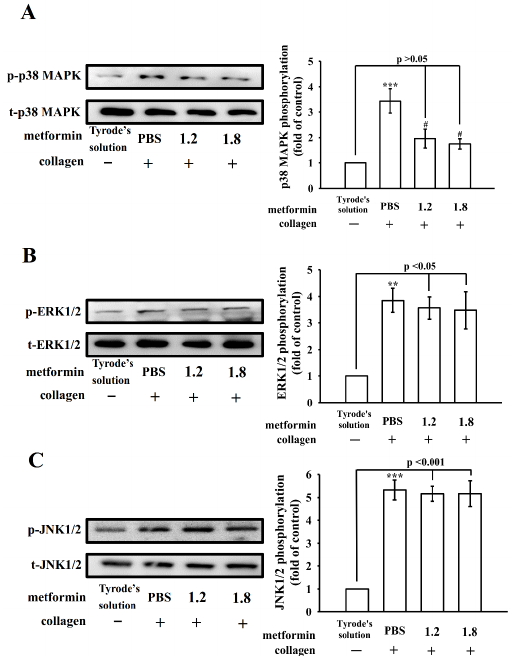
Figure 6. Regulatory activity of metformin in mitogen-activated protein kinase phosphorylation in platelets. Washed platelets were preincubated with PBS or metformin (1.2 and 1.8 mM) and treated with collagen (1 μ g/mL) for immunoblotting of ( A ) p38 mitogen-activated protein kinase (p38 MAPK), ( B ) ERK1/2, and ( C ) JNK1/2 phosphorylation. Data are expressed as mean ± standard error of the mean ( n = 4). ** p < 0.01 and *** p < 0.001 vs. Tyrode’s solution; # p < 0.05 vs. PBS + collagen group. 3.5. Effect of Metformin in Phosphorylation of VASP Cyclic adenosine monophosphate (cAMP) and cyclic guanosine monophosphate (cGMP) are small cyclic monophosphates. These nucleotides are vital messengers in sev- eral signaling pathways involved in the regulation of multiple targets, especially in the phosphorylation of VASP. As presented in Figure 7, PGE 1 (20 nM) and NTG (10 μ M) trig- gered VASP ser157 and VASP ser239 phosphorylation, respectively; treatment with H89 (a pro- tein kinase A inhibitor; 100 μ M) and KT5823 (a protein kinase G inhibitor; 10 μ M) reduced VASP ser157 and VASP Ser239 phosphorylation, respectively. However, metformin (1.8 mM) had no significant effects on either type of VASP phosphorylation, indicating that cyclic nucleotides may not participate in metformin-mediated antiplatelet activation.